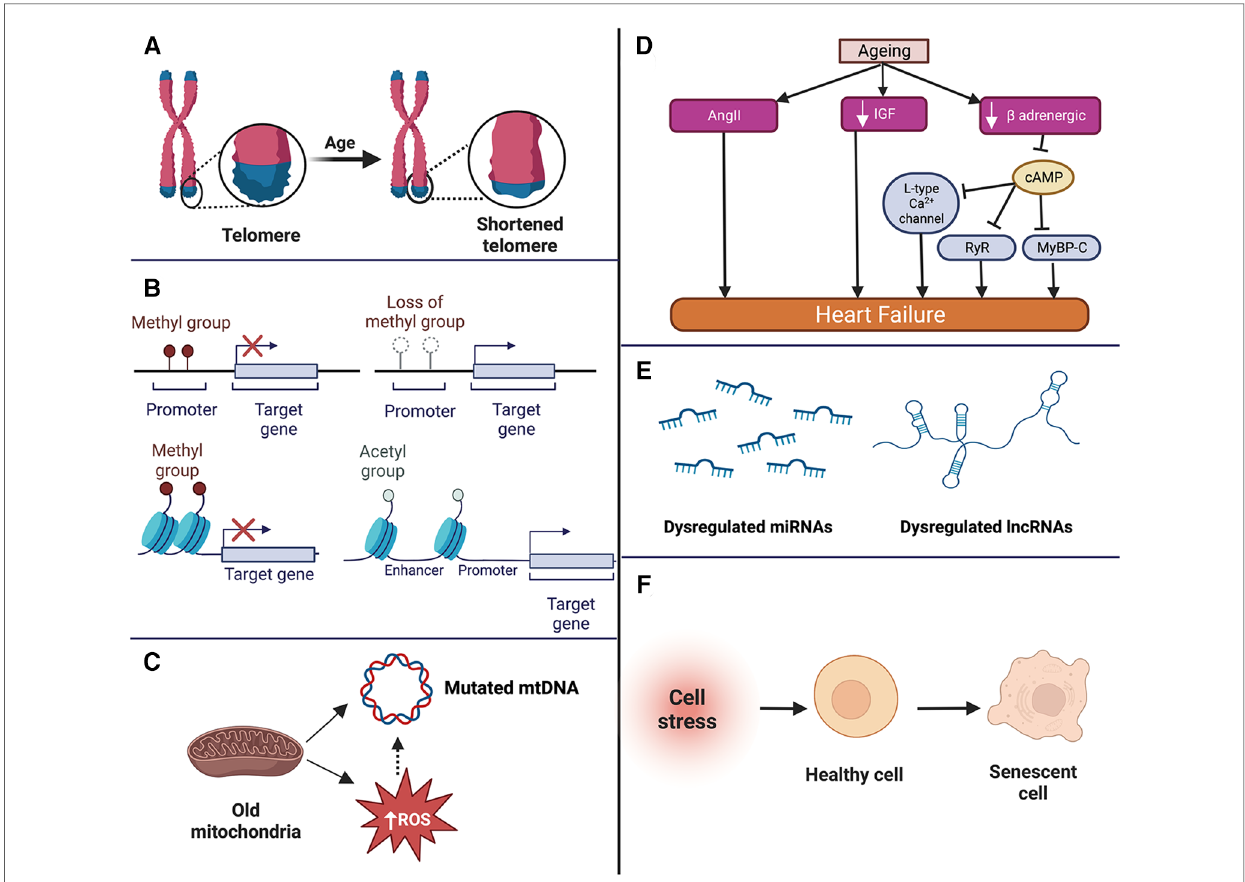
FIGURE 1 Summary of the molecular changes that occur in the aged heart such as telomere shortening ( A ), epigenetic changes ( B ), mitochondrial dysfunction ( C ), neurohormonal changes ( D ) dysregulation of non-coding RNAs ( E ), and cellular senescence ( F ). mtDNA, mitochondrial DNA; ROS, reactive oxygen species; miRNA, microRNA; lncRNA, long non-coding RNA; AngII, angiotensin II; IGF, insulin like growth factor; RyR, ryanodine receptor; MyBP-C, f Apoptosis of cardiomyocytes, loss of pacemaker cells, thickening and calci fi cation of the valves, and impairment of vascular structure and